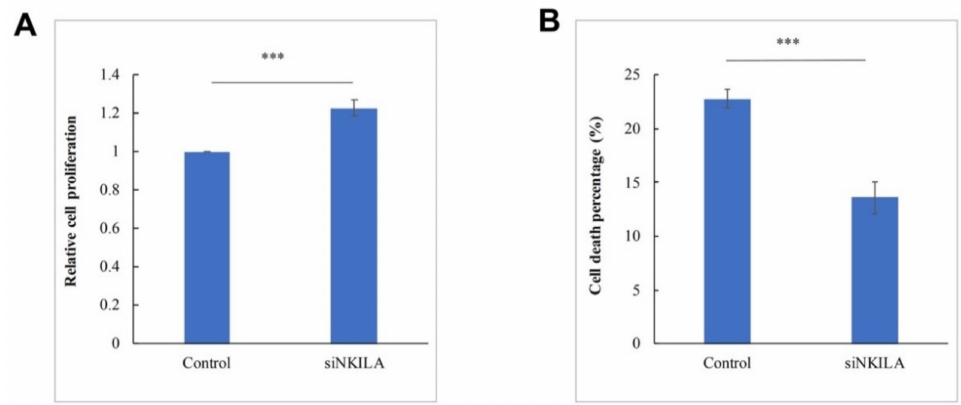
Figure 5. NKILA suppresses cell growth and promotes cell death in SU-DHL-1. ( A ) Cellular prolifer- ation upon knockdown of NKILA is studied using the trypan blue assay at 48 h post-transfection. Columns represent mean +/ − 1SD from five independent experiments. ( B ) Cell death upon knock- down of NKILA is studied using the trypan blue exclusion assay at 24 h post-transfection. Columns represent mean +/ − 1SD from three independent experiments. si NKILA : NKILA -targeted siRNA. ***: p -value <